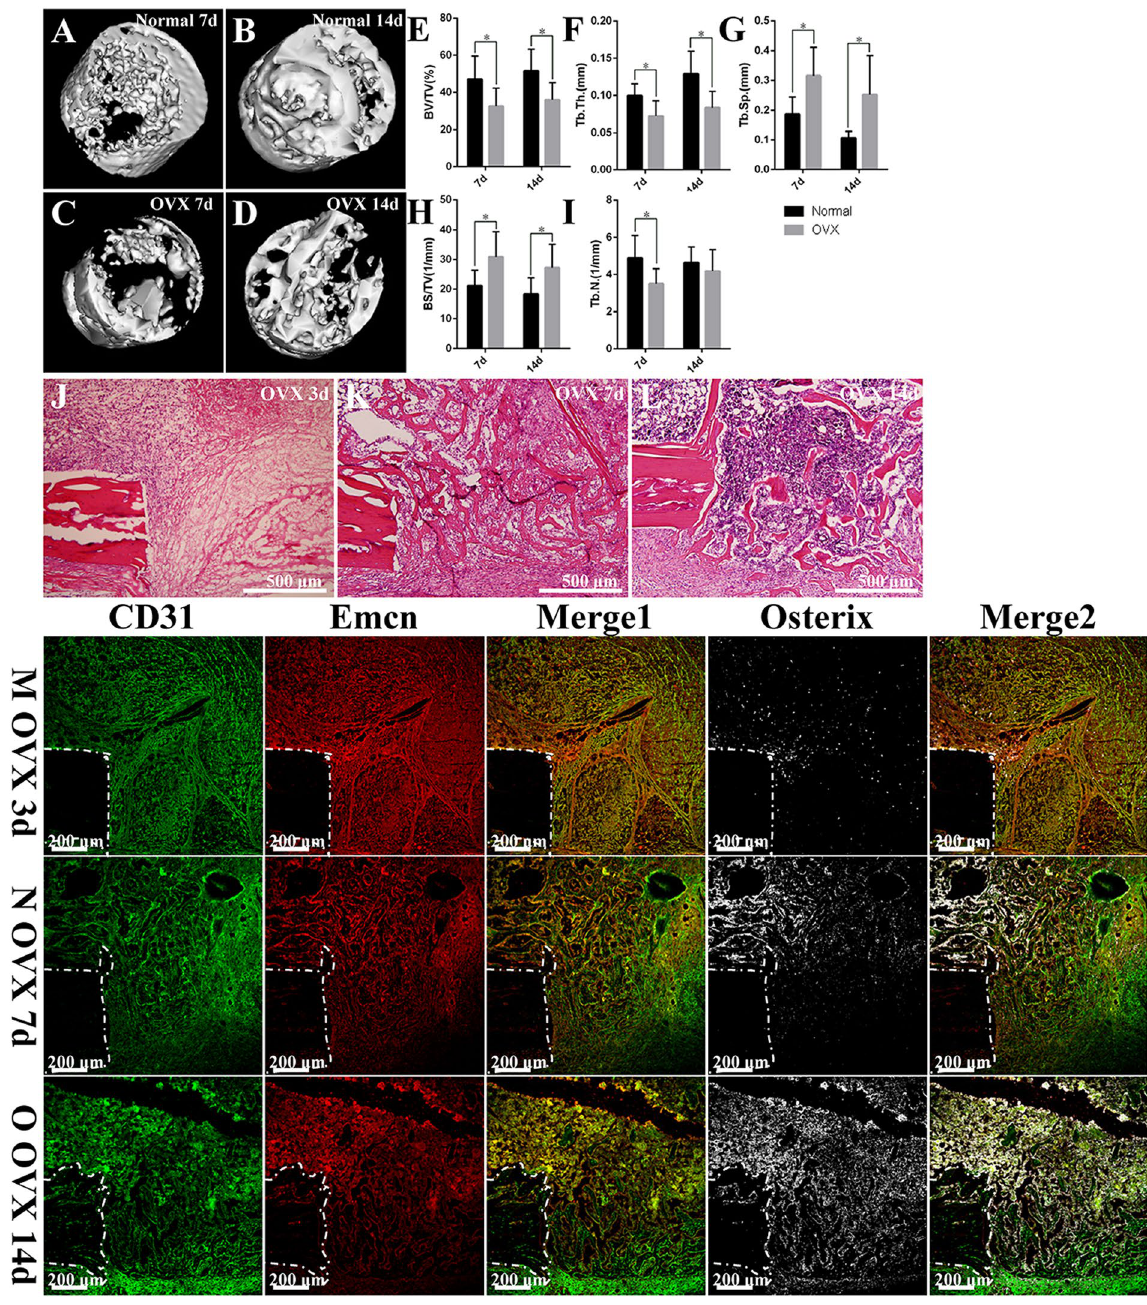
Figure 5. The repair process of the tibia drilling bone defect model in OVX rats. ( A–D ) Three-dimensional reconstruction after micro-CT scanning showed that new bones formations during the repair process at 7 and 14 days post-injury in OVX rats were lower than those in normal rats. ( E–I ) Statistical comparisons of BV/TV, Tb.Th., Tb.Sp., BS/TV and Tb.N. between normal rats and OVX rats at 7 and 14 days post-injury. * P < 0.05, n = 4. ( J–L ) H/E staining at different time points in the repair process of tibia drilling bone defect in OVX rats. The degree of hematoma organization at 3 days post-injury in OVX rats was obviously inadequate compared with that in normal rats (Fig. 1). The thickness of new trabecular bones was reduced at 7 days post-injury in OVX rats. The number and thickness of trabecular bones reduced, but the space increased at 14 days post-injury in OVX rats. ( M–O ) The proliferation and distribution of CD31hiEmcnhi vessels and osterix + cells at different time points during the bone defect repair process in OVX rats. Compared with the repair process in normal rats, the area of CD31hiEmcnhi vessels was decreased at every time points in OVX rats. The high distribution of CD31hiEmcnhi vessels at the surface of trabecular bones near the frontier growth area at 7 days post-injury was not obvious. There was no high distribution of CD31hiEmcnhi vessels at the surface of the trabecular bones near the lateral margin of cortical bone at 14 days post-injury. The areas of osterix-staining positive at the repair region were decreased at 3, 7 and 14 days post-injury in OVX rats compared with those in normal